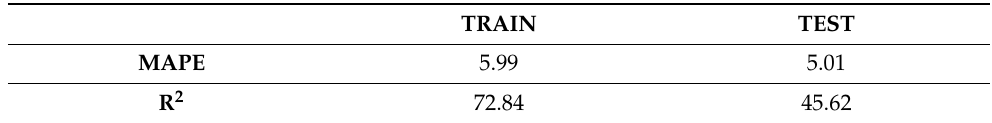
Figure 14. MAPE over a horizon of 1 day (5 min × 12 × 24 data points to be predicted) in the humidity variable. Table 2. Error metrics for the humidity